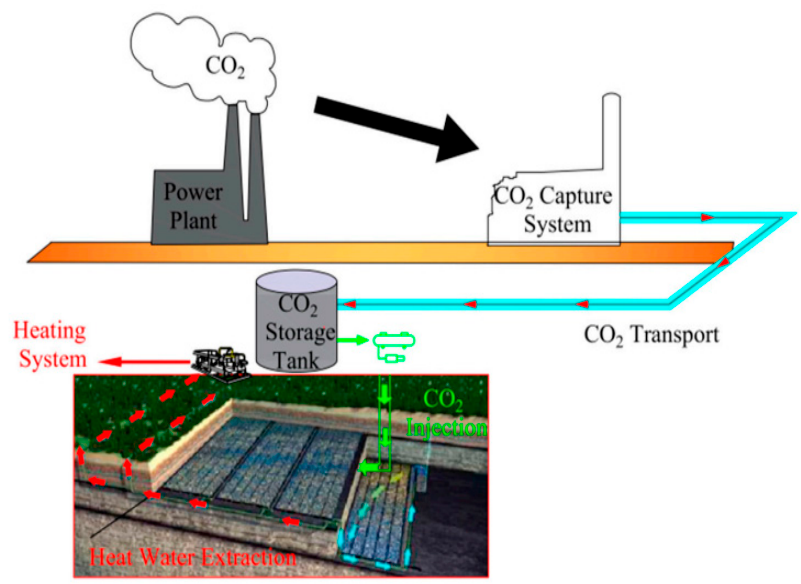
Figure 6 . CO 2 sequestration in coal mines (Wang [39])